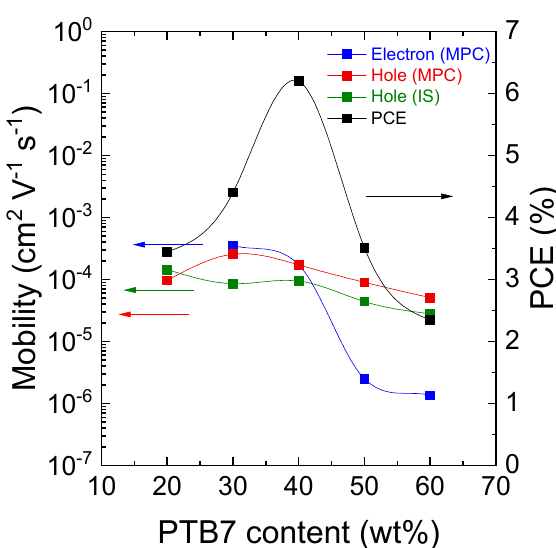
Figure 8. PTB7 content dependency of electron and hole mobility and PCE. Hole mobility determined by impedance spectroscopy (IS) is also shown.